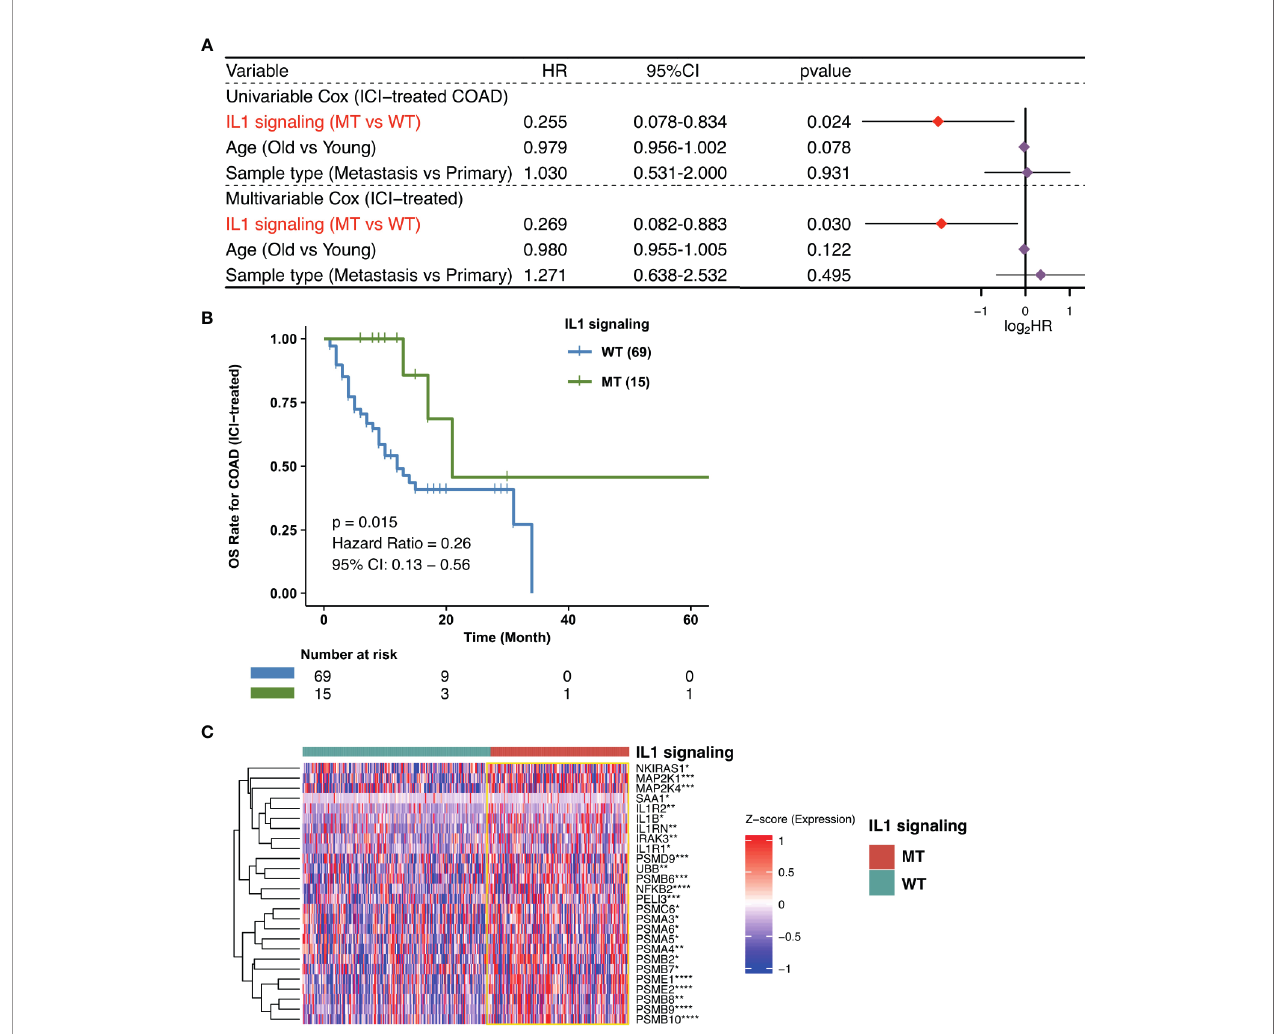
FIGURE 1 | Predictive values of clinical characteristics and the IL-1 signaling mutation status on ICI outcomes. (A) Forest plot of the results of the univariate Cox and multivariable Cox regression models. In the univariate Cox regression analysis, the factors with a p value below 0.05 were IL-1 signaling MT. Multivariate Cox regression analysis showed that the IL-1 signaling mutation status was an independent predictor of ICI therapy in COAD patients. The main part of the forest plot presents the risk ratio (HR) and 95% con fi dence interval (95% CI), where red dots indicate P < 0.05. The HR indicates predictors of favorable (HR < 1) or poor (HR > 1) OS. (B) Kaplan-Meier survival curves for the OS of 84 COAD patients in the ICI-treated cohort. We performed KM survival analysis on different subgroups of patients (IL-1 signaling mutation status). (C) Heatmap for the expression of markers related to IL1 signaling. (*P < 0.05; **P < 0.01; ***P < 0.001; ****P < 0.0001; Mann-Whitney U